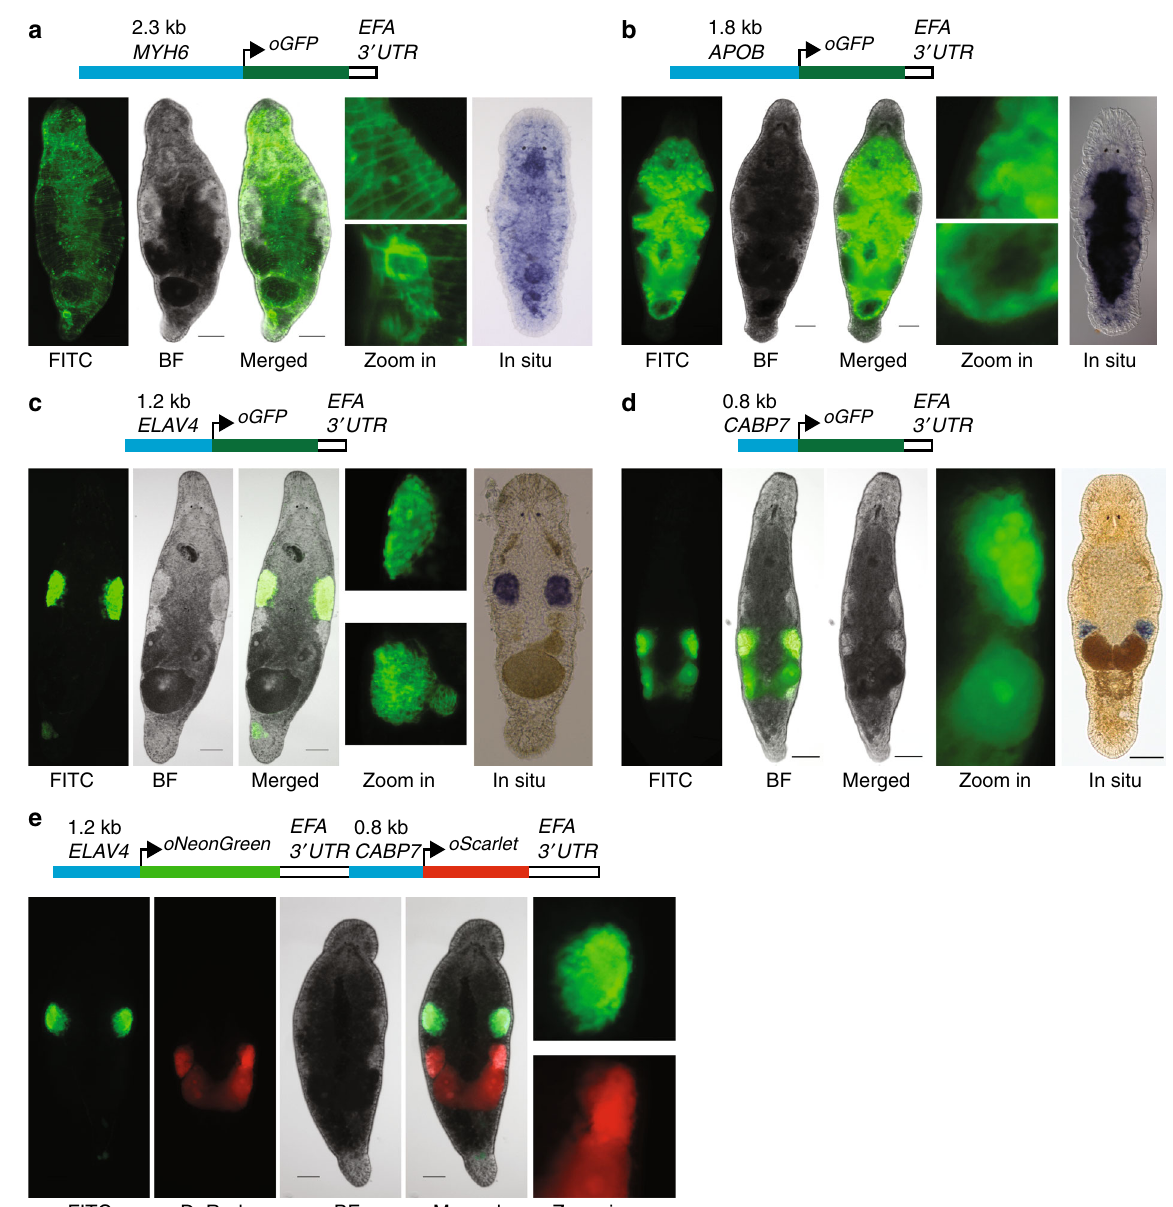
Fig. 3 Tissue-speci fi c promoter transgenic lines. a NL9 line expressing GFP under the muscle-speci fi c promoter of the MYH6 gene. Zoom in — detailed images of the body wall (top) and stylet (bottom); In situ — whole-mount in situ hybridization expression pattern of MYH6 transcript. b NL22 line expressing GFP under the gut-speci fi c promoter of the APOB gene. Zoom in — detailed images of the gut side (top) and distal tip (bottom); In situ — whole- mount in situ hybridization expression pattern of the APOB transcript. c NL21 line expressing GFP under the testis-speci fi c promoter of the ELAV4 gene. Zoom in — detailed images of the testis (top) and seminal vesicle (bottom); In situ — whole-mount in situ hybridization expression pattern of the ELAV4 transcript. d NL23 line expressing GFP under the ovary-speci fi c promoter of the CABP7 gene. Zoom in — detailed image of the ovary and developing egg; In situ — whole-mount in situ hybridization expression pattern of the CABP7 transcript. e NL24 line expressing in a single construct NeonGreen under the testis-speci fi c promoter of the ELAV4 gene and Scarlet-I under the ovary-speci fi c promoter of the CABP7 gene. Zoom in — detailed images of the testis (top) and ovary (bottom) regions. FITC — FITC channel; DsRed — DsRed channel; BF — bright- fi eld. Scale bars are 100 μ